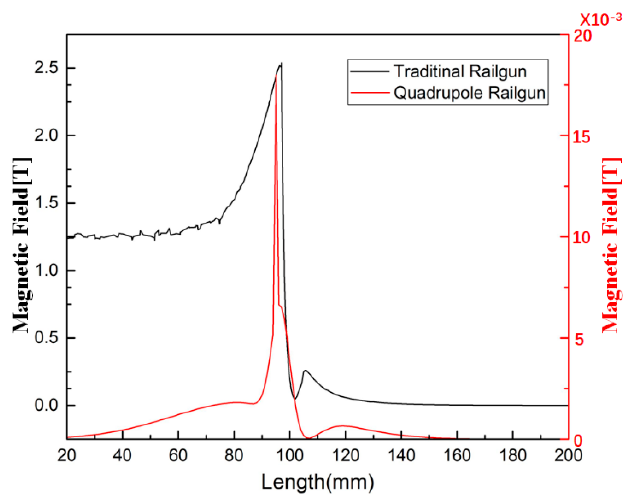
Figure 13. The distribution of the magnetic field in the center of the railgun bore.